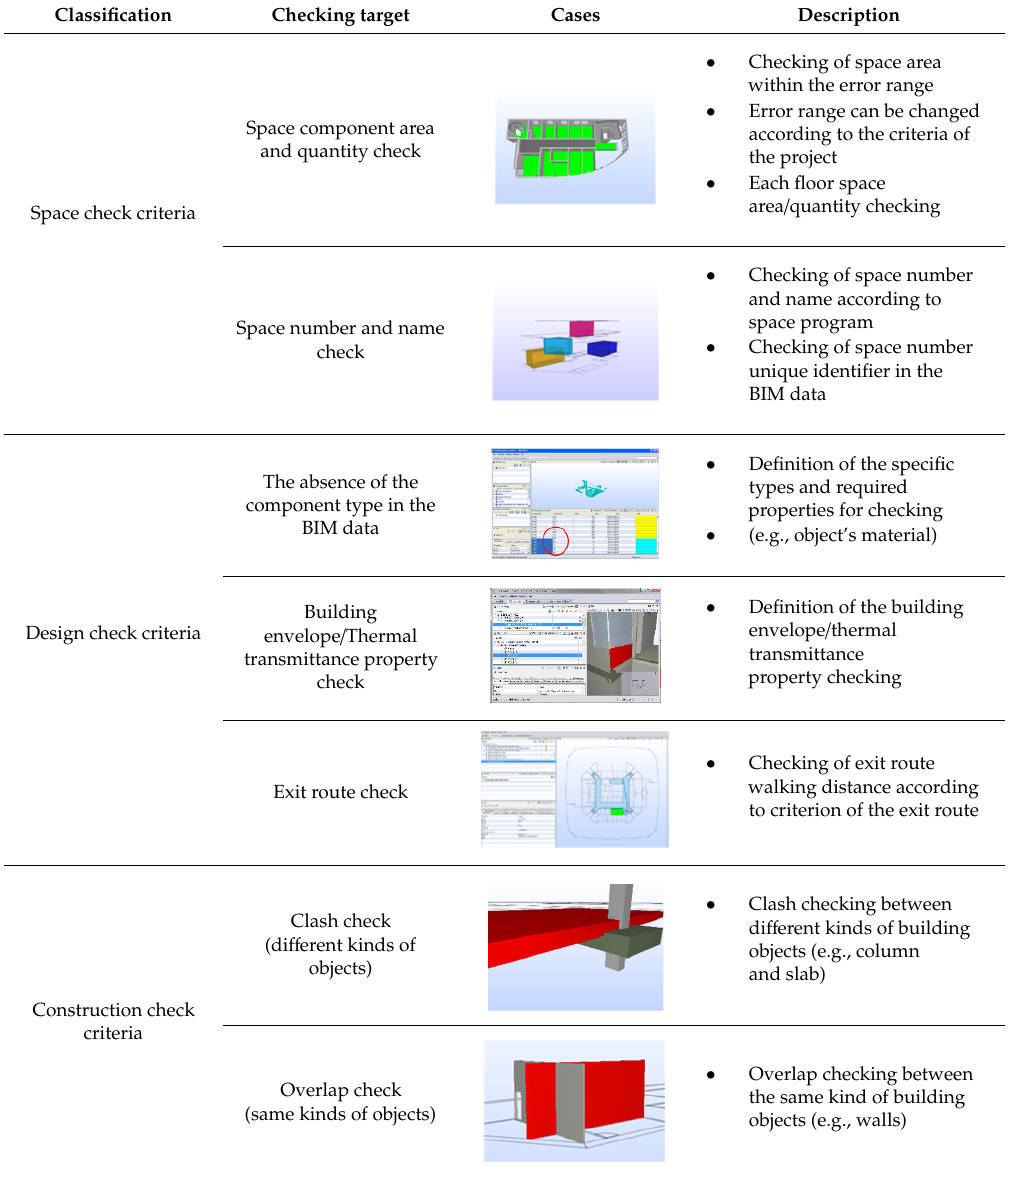
Table 6. Quality check targets and cases.